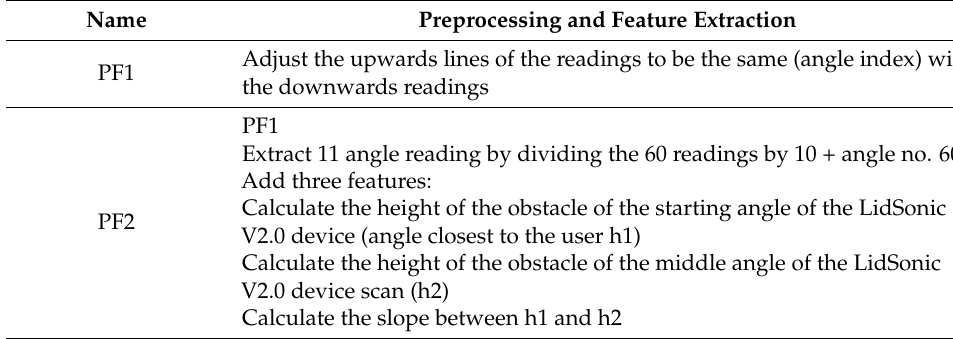
Table 4. Preprocessing and Feature Extraction.